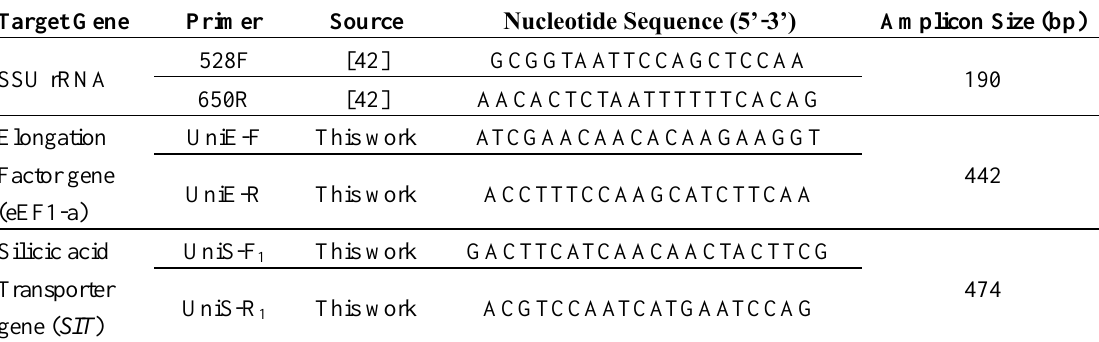
Table 1. Universal primers for DNA amplification of genomic fragments of eEF1-a and SIT genes.